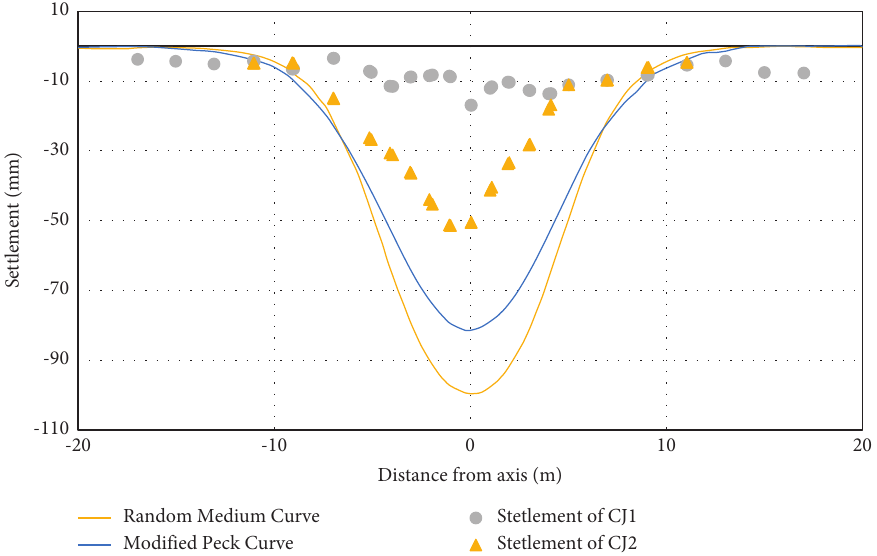
Figure 19: Modified Peck curve, random medium curve, and cumulative maximum settlement (CJ1,